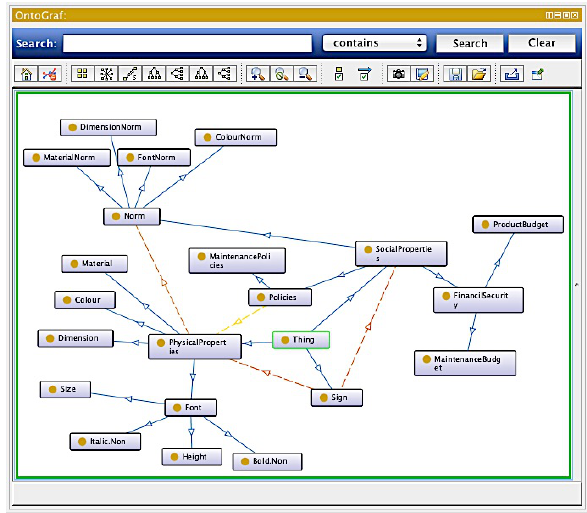
Figure 7. Semantic network of "Sign" (including social and physical properties)